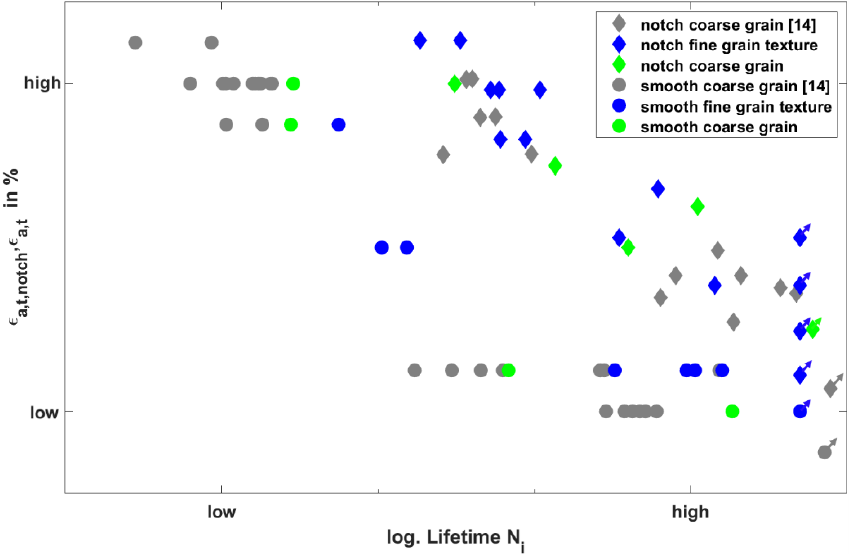
Figure 5. Total strain amplitude Wöhler curve for smooth and notched specimen with different grain orientation distributions for isothermal LCF tests at 850 °C.